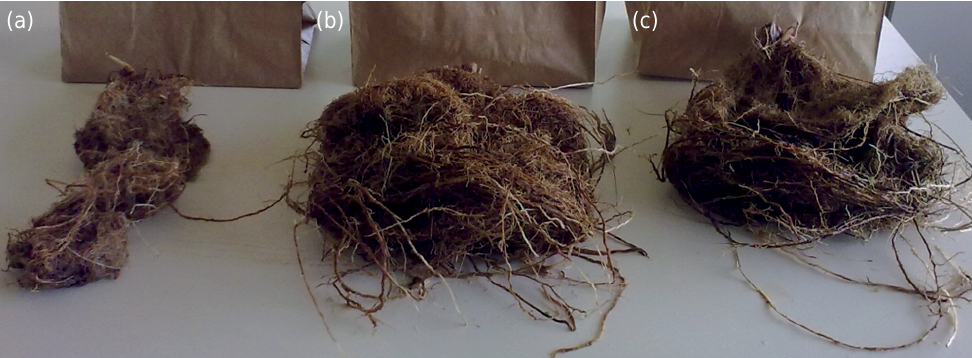
Figure 2. Sugarcane roots of variety RB 93 5744 grown under controlled greenhouse conditions in sandy soil and inoculated or not with Azospirillum brasilense strains Ab-V5 and Ab-V6, with different levels of mineral-N: (a) non-inoculated plants grown with 2 mg L -1 of N; (b) non-inoculated plants grown with 2 mg L -1 of N; (c) plants inoculated with Ab-V5 + Ab-V6 and receiving 2 mg L -1 of N. Photo: Dr. Leopoldo Sussumu